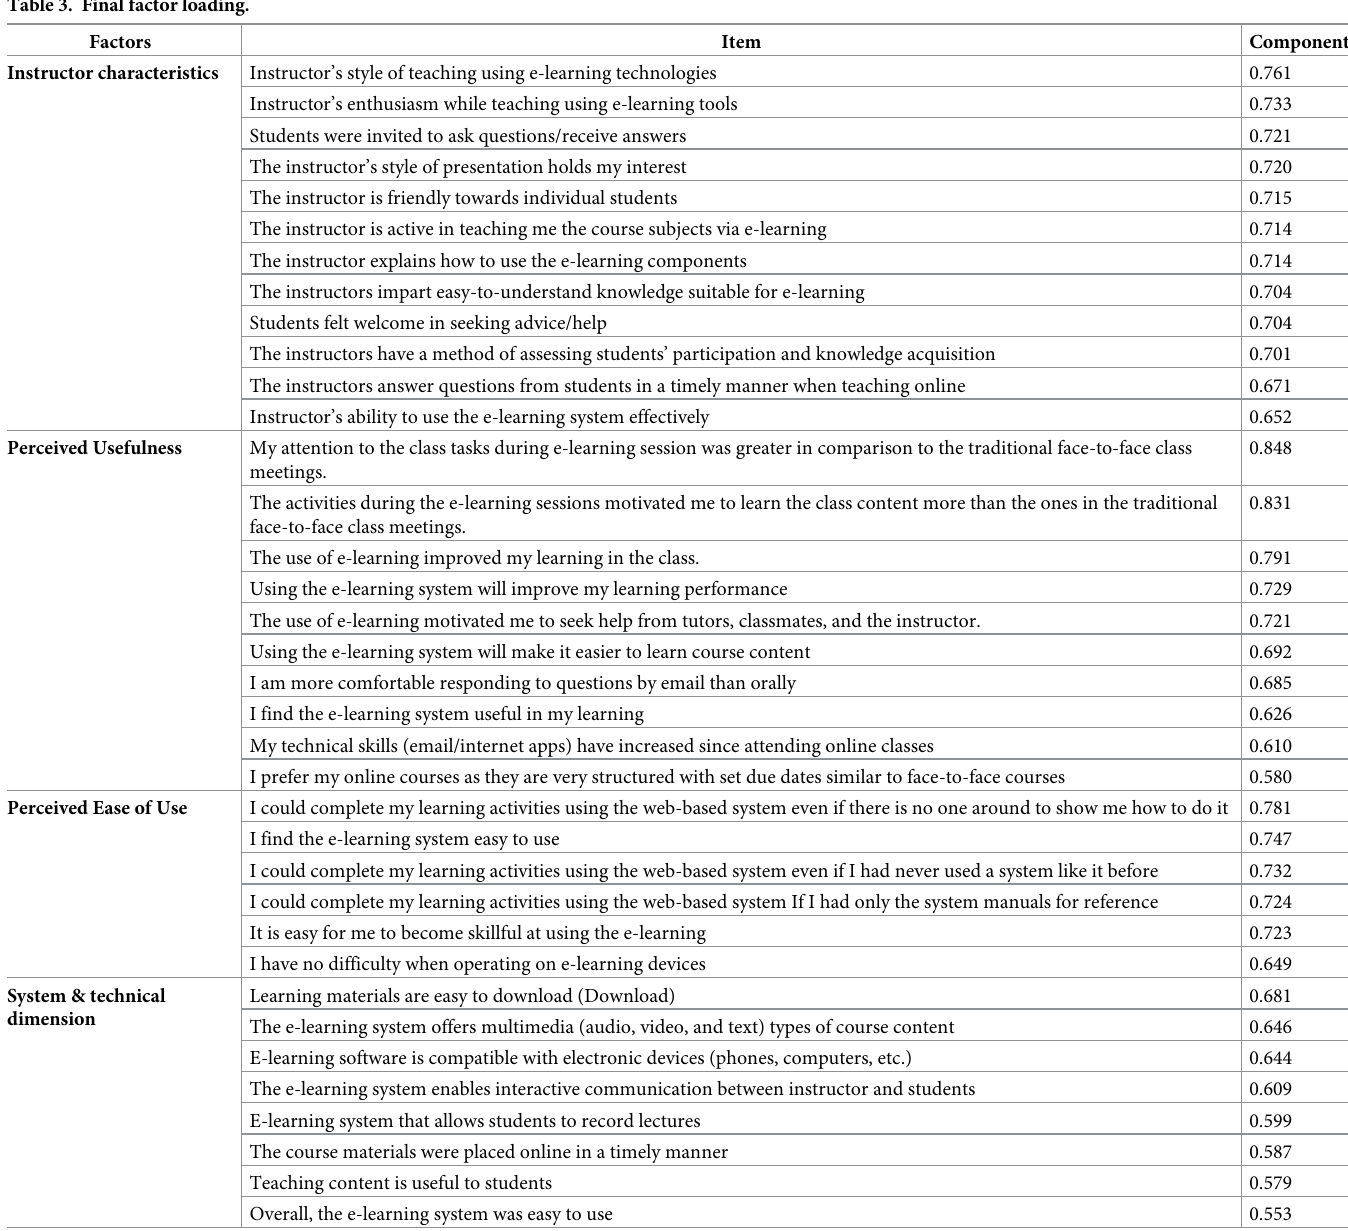
Table 3. Final factor